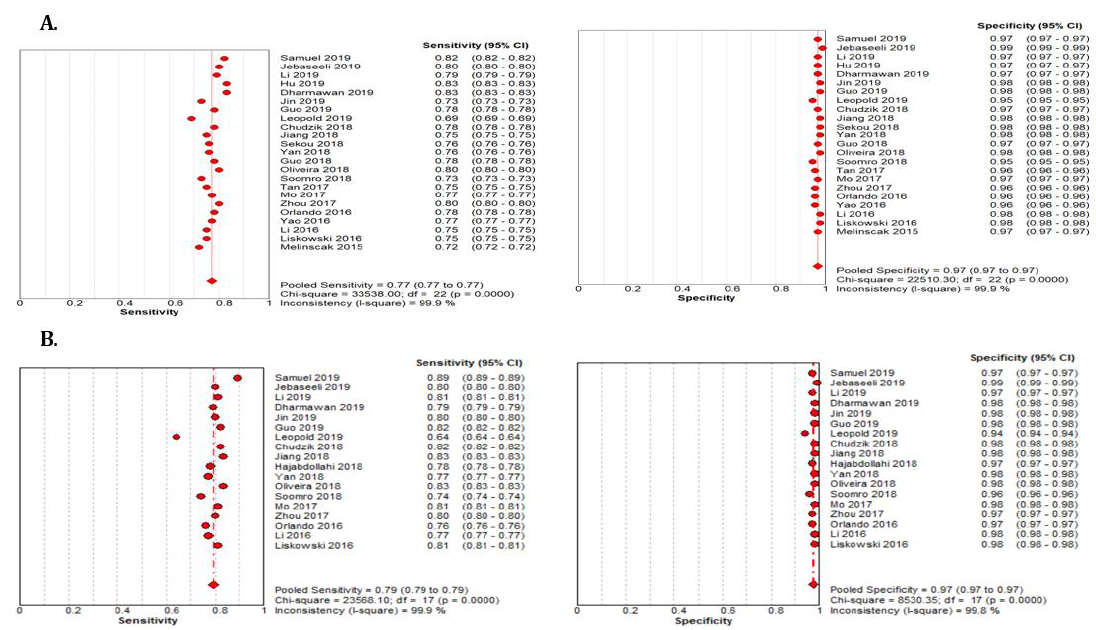
Figure 9. Performance of the DL model retinal vessel segmentation ( A ) pooled sensitivity and specificity of DRIVE dataset ( B ) pooled sensitivity and specificity of the STARE dataset.